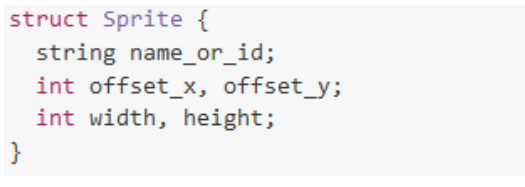
Fig. 23. Example object structure for